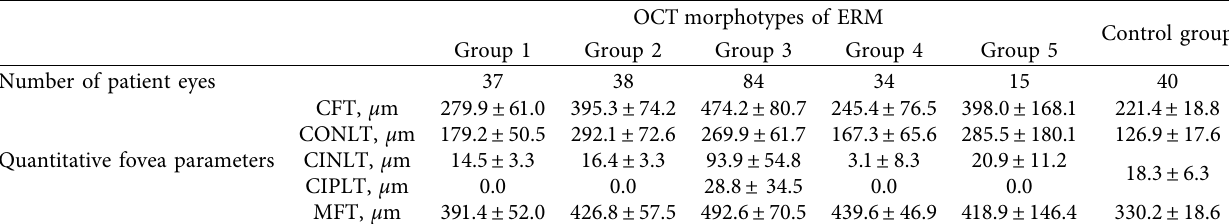
Quantitative fovea parameters